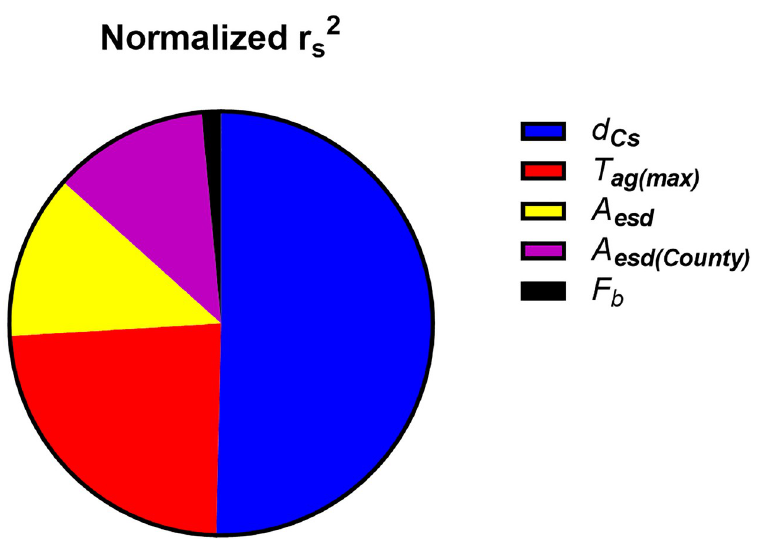
Fig 7. Fraction of correlation contributed by each parameter given in Table